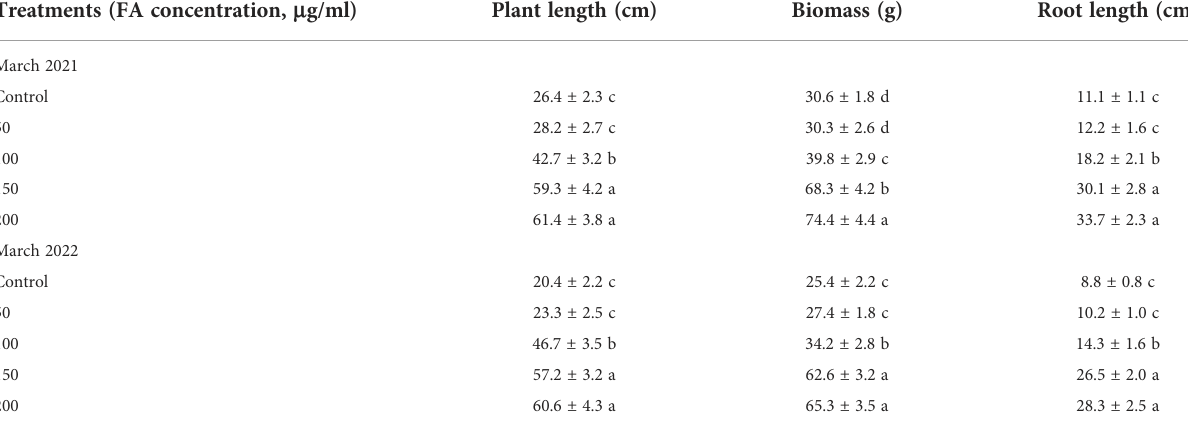
TABLE 1 Effect of different concentrations of FA on tomato plant growth inoculated with bacterial wilt pathogen in pot experiment. Treatments (FA concentration, m